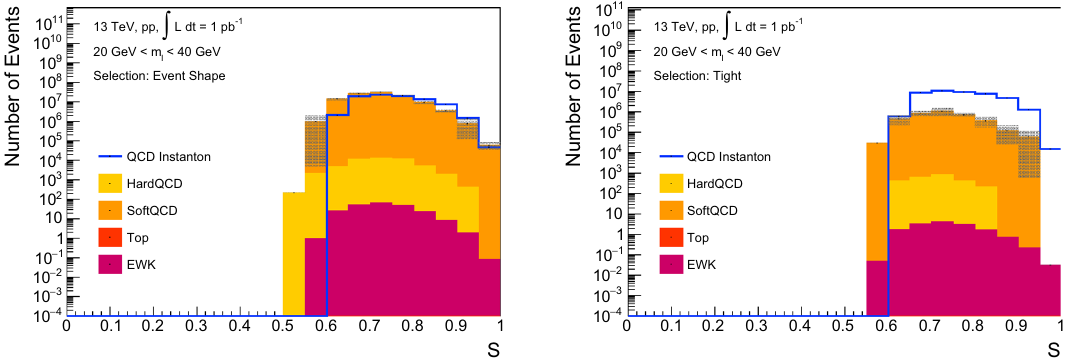
Fig. 11 Predicted distributions of the event sphericity for various pro- cesses,weightedbytheirpredictedcrosssectionsforanintegratedlumi- (cid:8) nosity of L = 1pb − 1 after the event-shape based selected (left) and tight selection (right). The invariant mass of all reconstructed tracks is